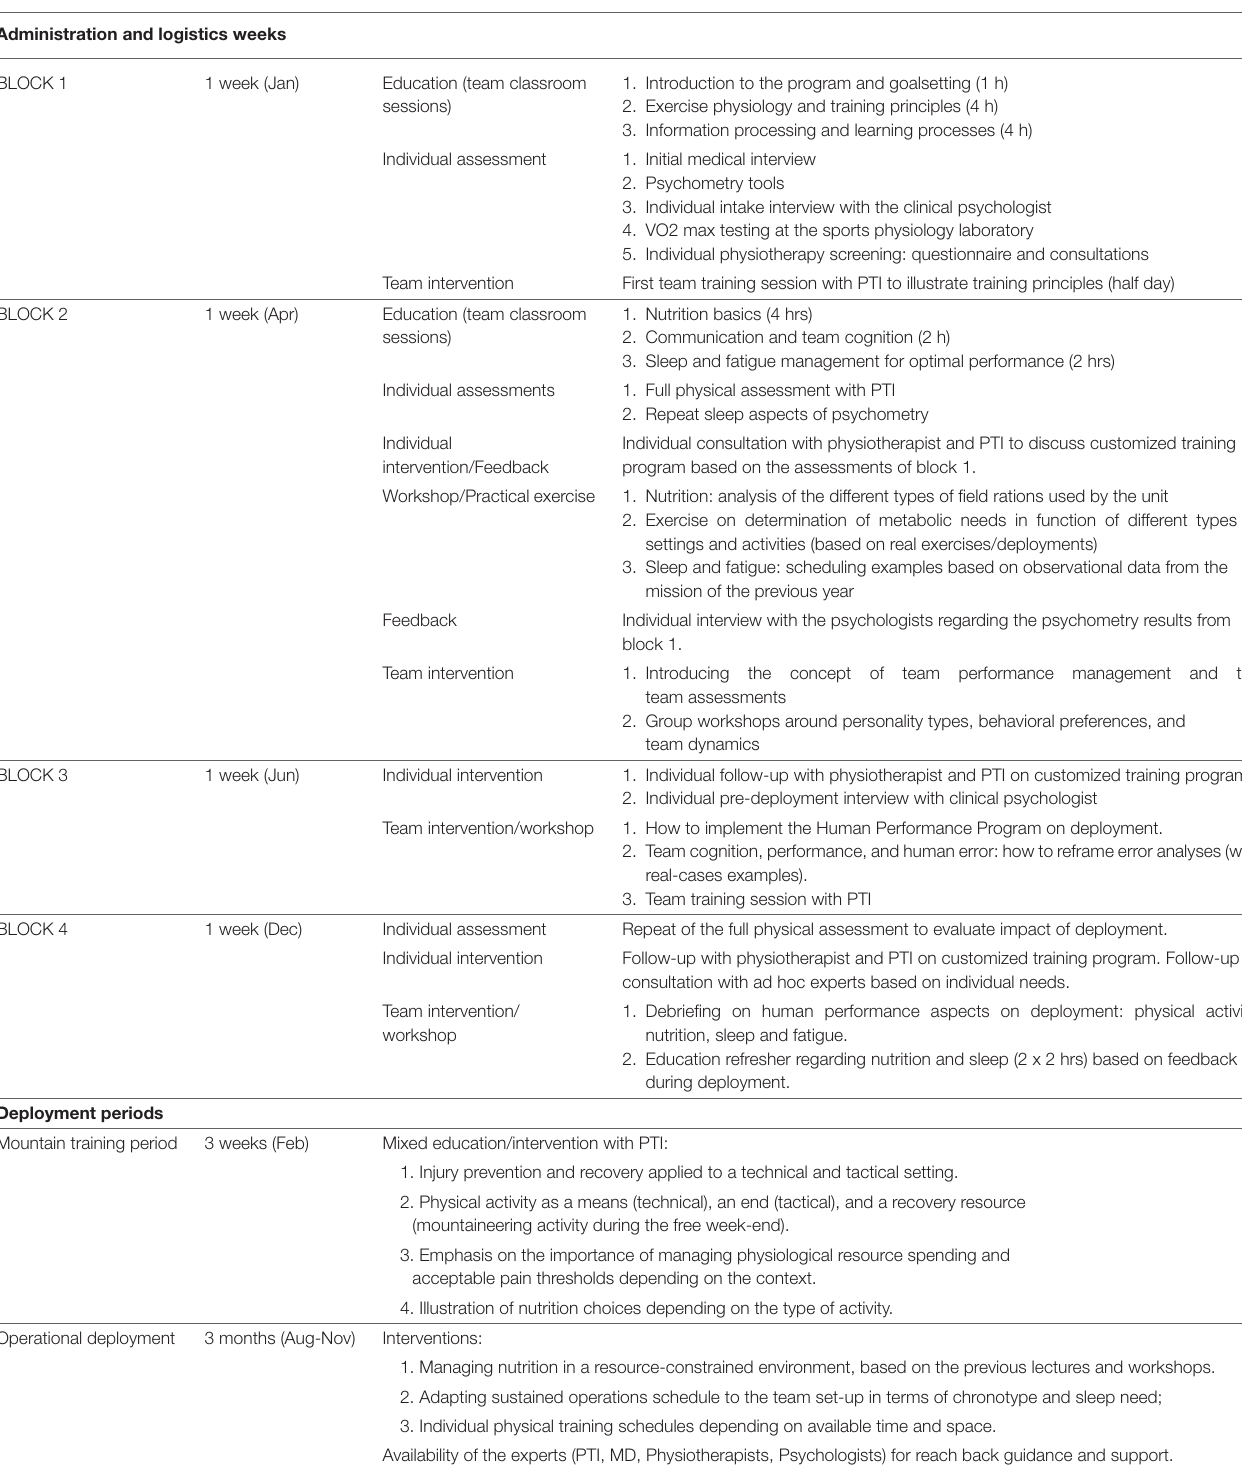
TABLE 4 | Implementation